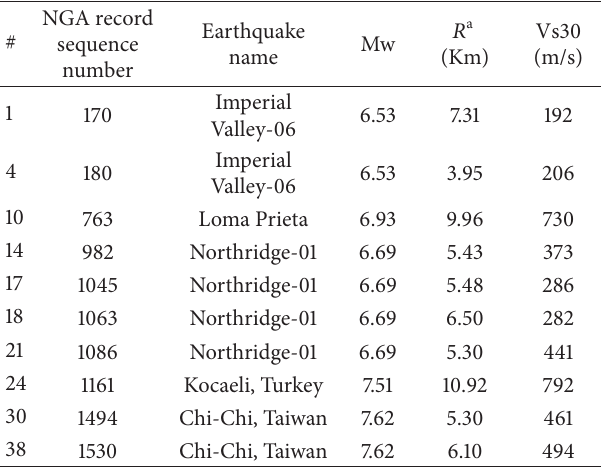
Figure 3: The schematic configuration of the developed numerical model.